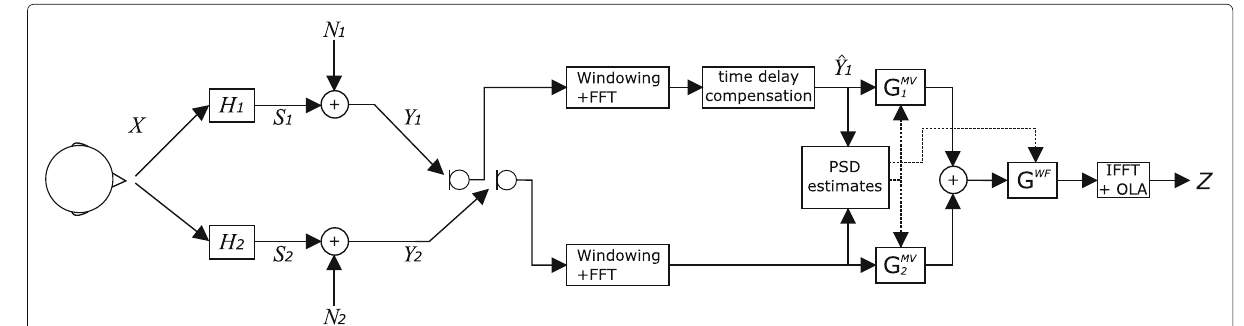
Fig. 1 Block diagram of the signal model and the proposed